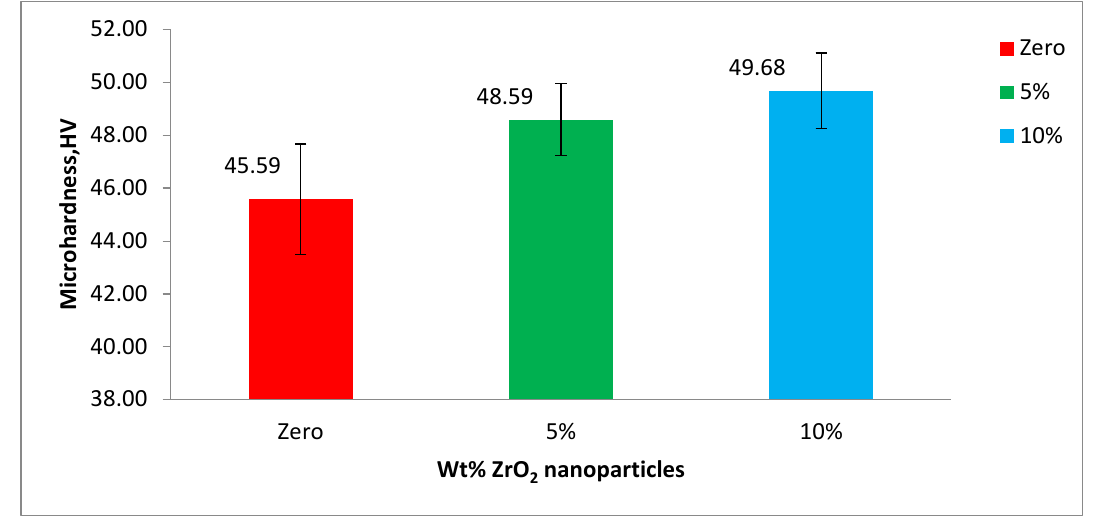
Figure 9. Mean hardness (VHN) of the tested groups of PMMA.